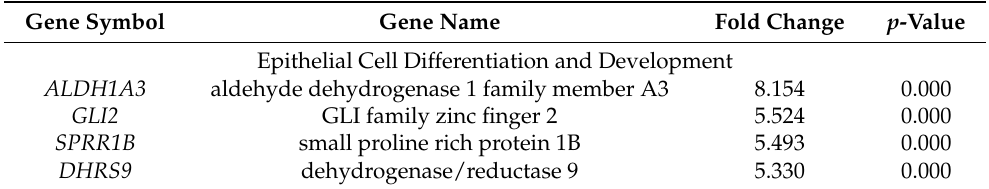
Table 2. List of genes involved in epithelial cell differentiation and development and cell proliferation in HT-29 cells stimulated with